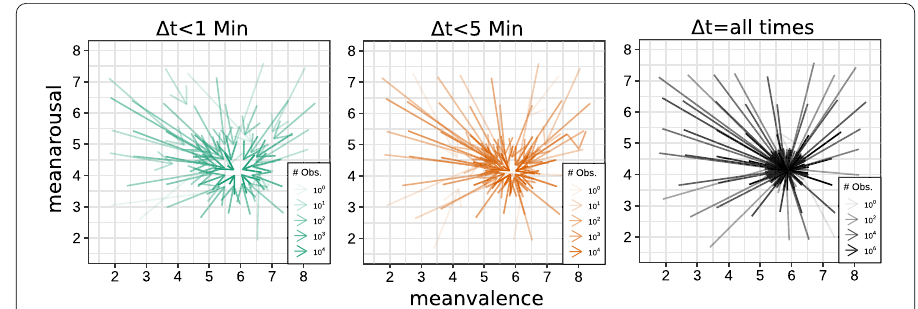
Figure 2 Changes in expressed valence and arousal on different timescales. Arrows start at the mean point of valence and arousal values in a 9 × 9 grid and end in the mean value of the valence and arousal of the next status update (see [10] for a similar plot using self-reports). Valence and arousal return quickly to a point with valence above 5 and arousal around 4. Emotional expression relaxes quickly but not instantly, as changes in short timescales are directed towards the baseline position but do not fully converge. Arrow transparency corresponds to the number of observations in the bin